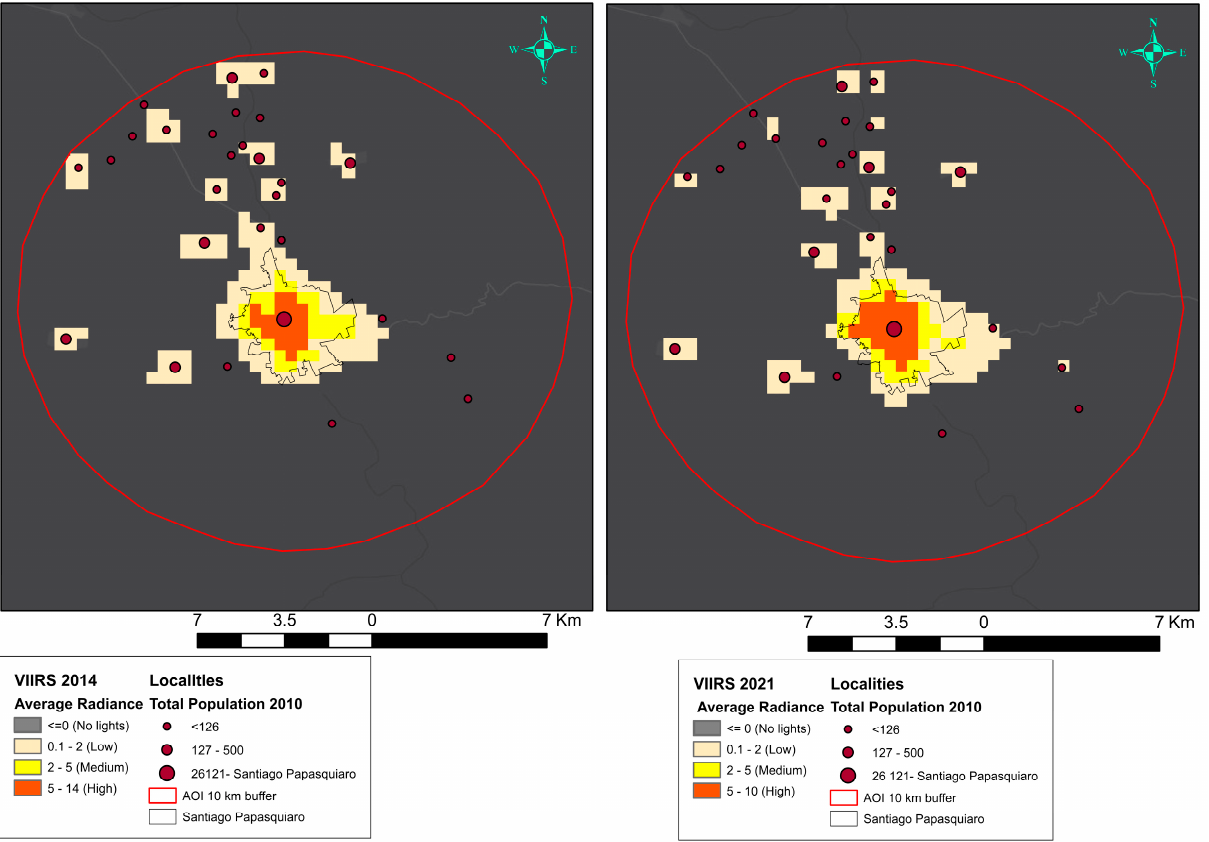
Figure 6. Average radiance brightness and total population in 2014 and 2021.